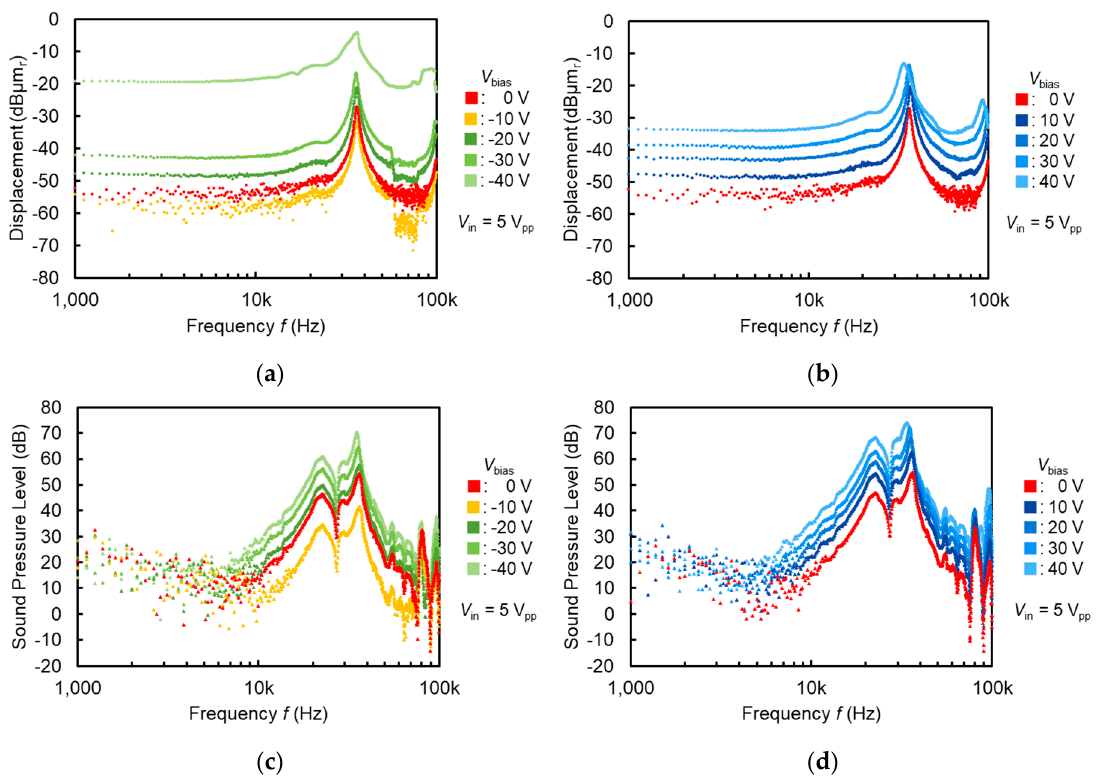
Figure 12. Electromechanical and acoustic characteristics of out-of-plane φ = 2.0 mm membrane